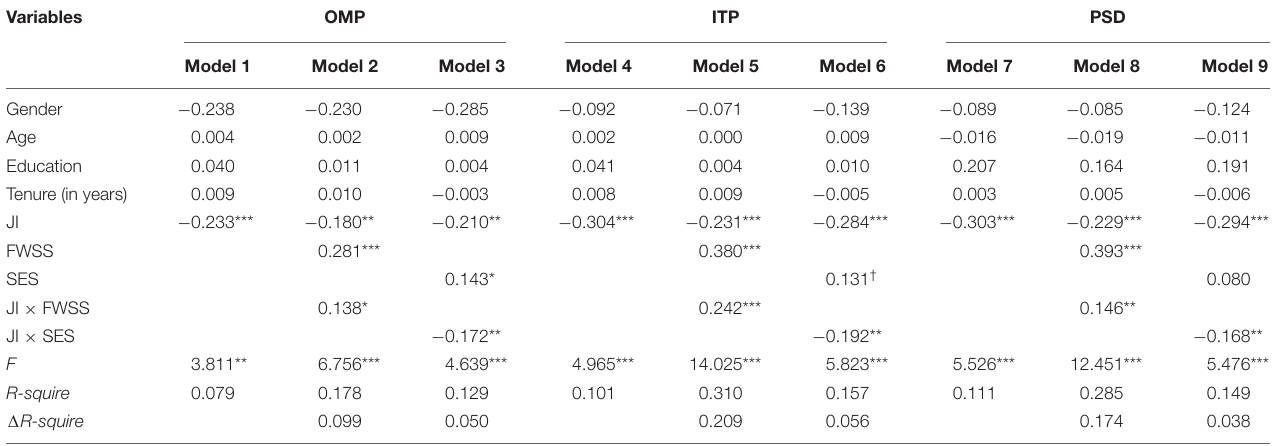
TABLE 3 | Hierarchical regression results of two-way interactive role on proactive